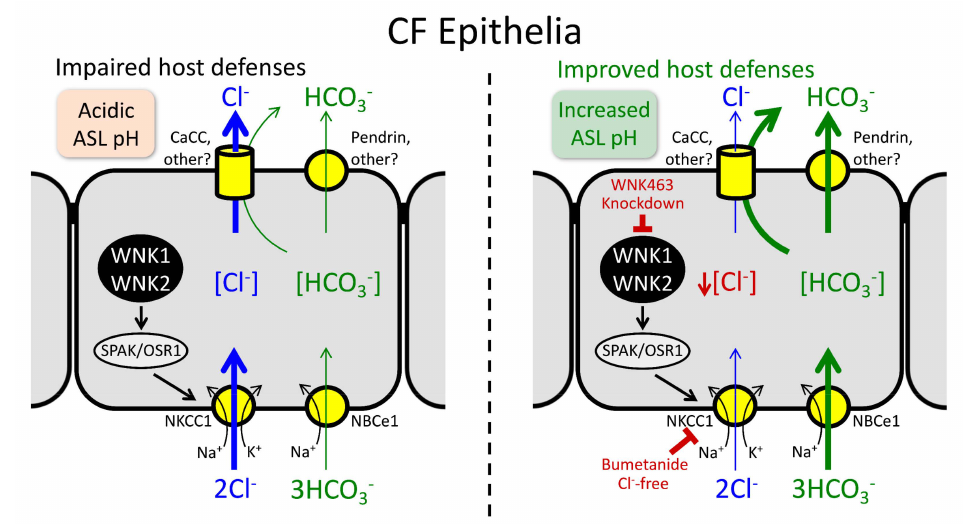
Figure 4. WNK kinases regulate HCO 3 − versus Cl − secretion across human airway epithelia. Model shows the with-no-lysine [K] (WNK) kinase signaling pathway in human CF airway epithelia lacking functional CFTR. Left panel: WNK1 and WNK2 signal via intermediate Ste20/SPS1-related proline- alanine-rich protein kinase/oxidative stress responsive 1 kinase (SPAK/OSR1) to regulate basolateral Na + -K + -2Cl − cotransporter (NKCC1) activity. Right panel: reducing WNK activity, inhibiting NKCC1, or removing Cl − from basolateral solution lower the intracellular [Cl − ]. At the same